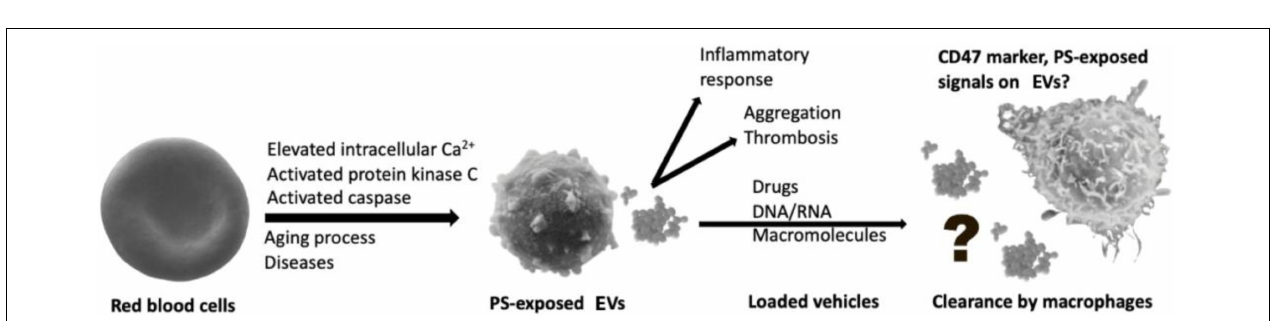
FIGURE 6 | Remaining EVs after infection to THP-1 cells. ( ↓ ) DNA-extracellular vesicles (EVs; (EVs containing DNA plasmids) were stable within 48 h. ( ≤ ) DNA-EVs treated with Annexin V protein. ( λ ) THP-1-derivated macrophages M2. ( π ) DNA-EVs infected with macrophages M2. ( Υ ) DNA-EVs coated with Annexin V protein infected to THP-1 cells.